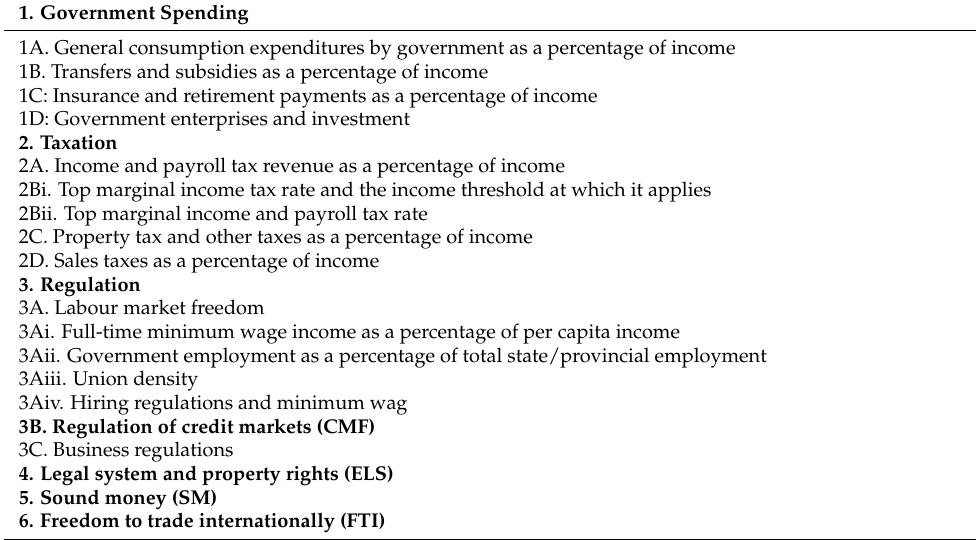
Table 1. Components of the Economic Freedom of North America